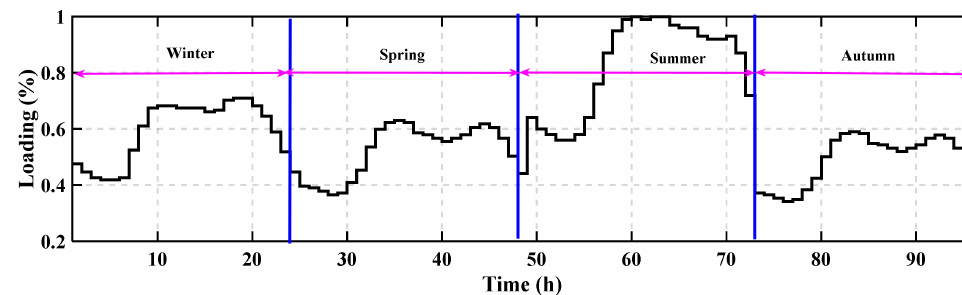
Figure 3. The seasonal load profile.